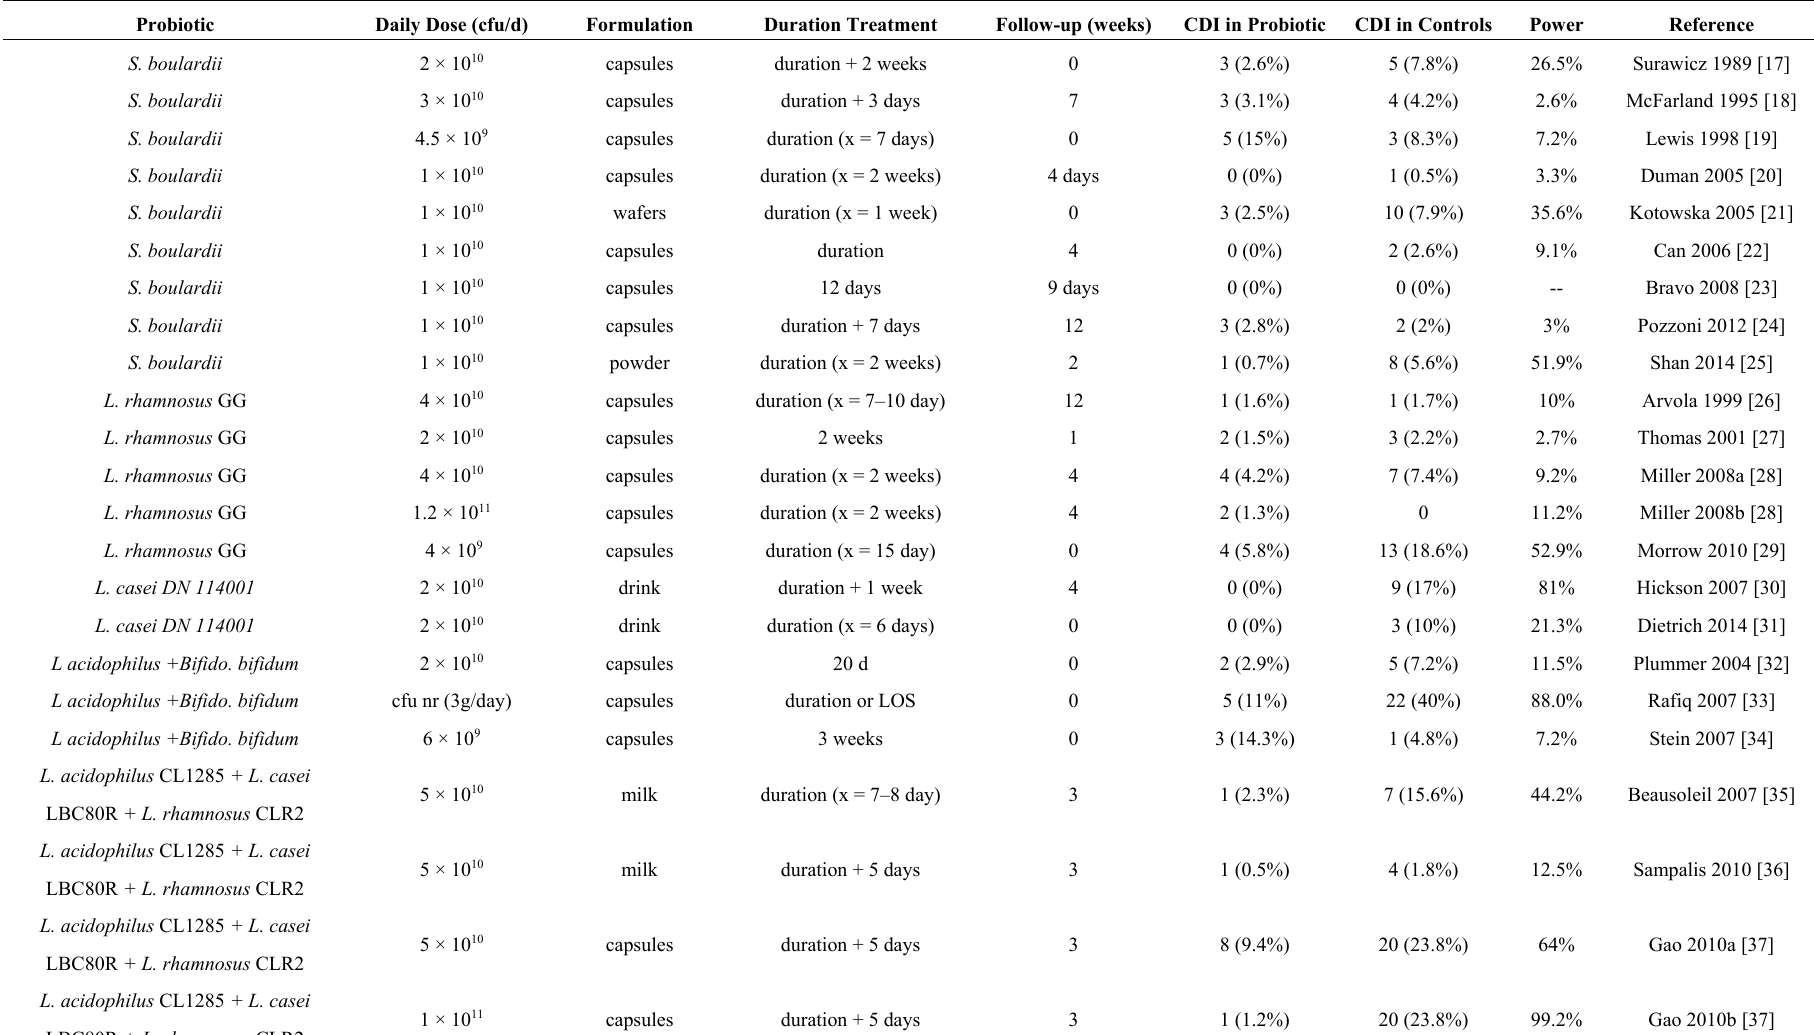
Table 3. Characteristics of probiotic and control treatments and rate of C. difficile infections (CDI) by group. Probiotic Daily Dose (cfu/d)